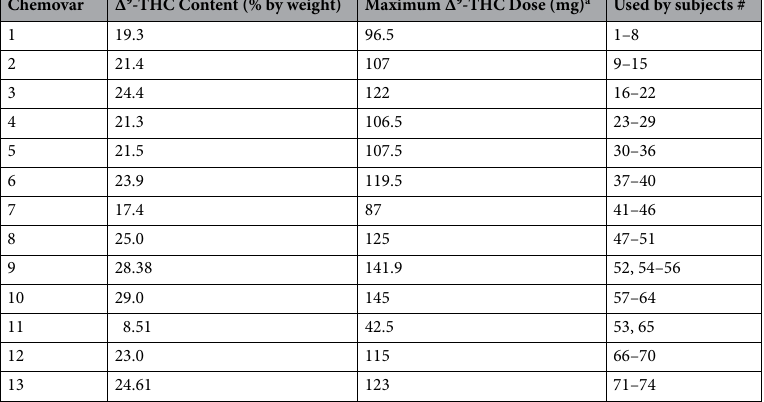
Table 2. The ∆ 9 -THC content information on cannabis chemovars smoked by study subjects. a Based on a 500- mg